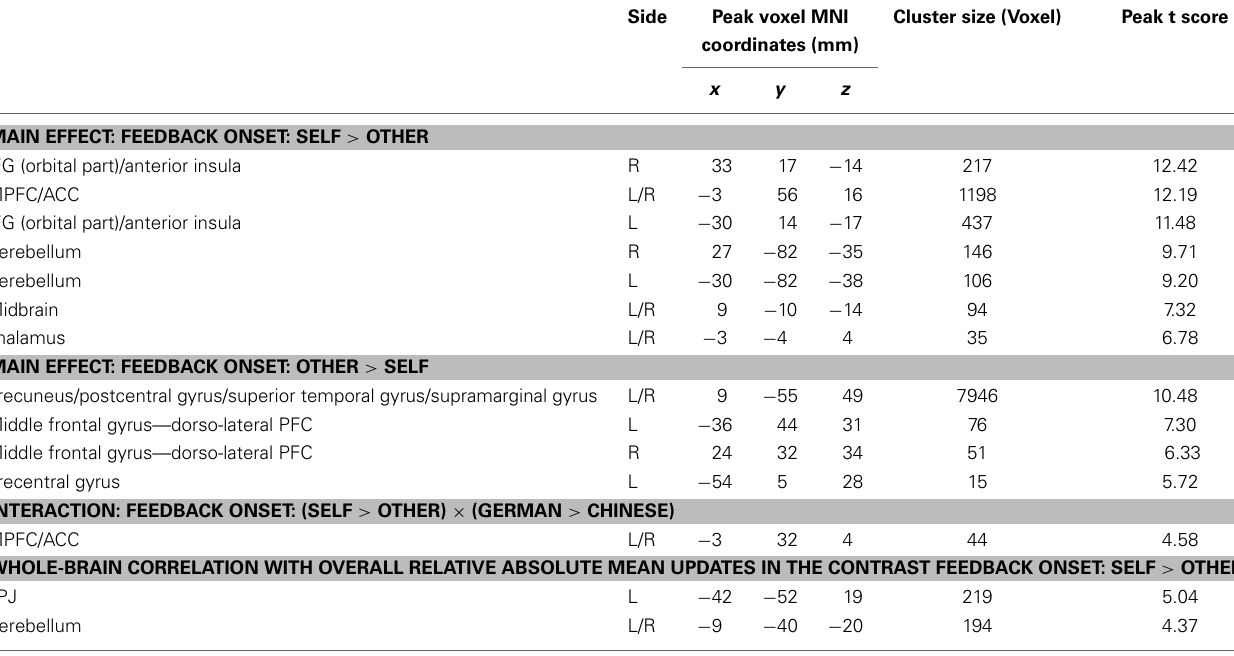
Table 3 | Significant activations in feedback